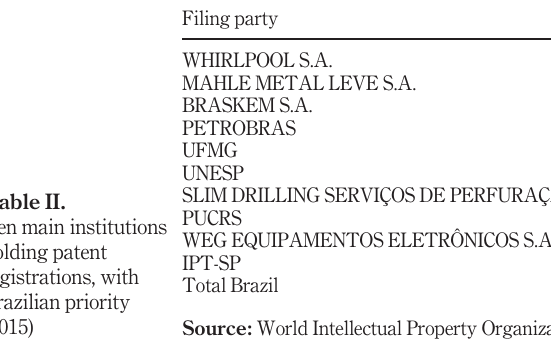
Table II. Ten main institutions holding patent registrations,